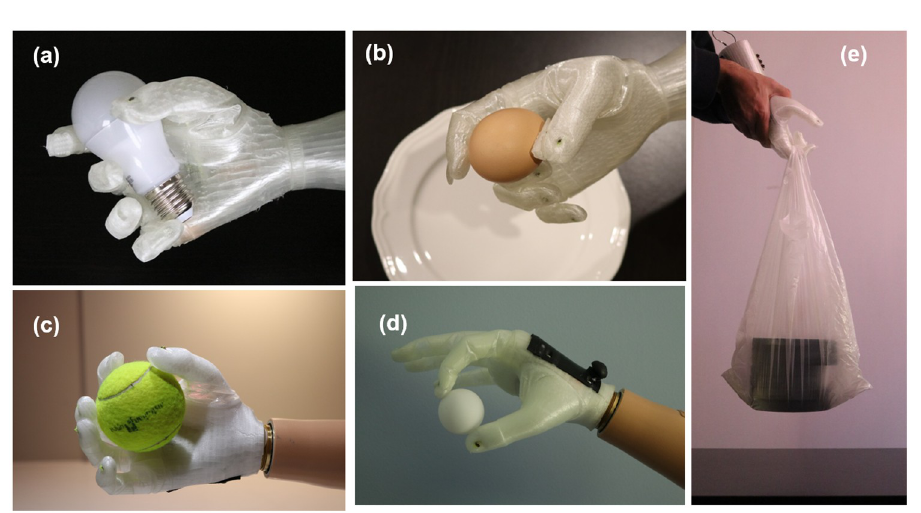
Fig 15. X-Limb performance in grasping delicate/fragile objects (a and b), spherical objects (c and d) and carrying 10kg weight (e).